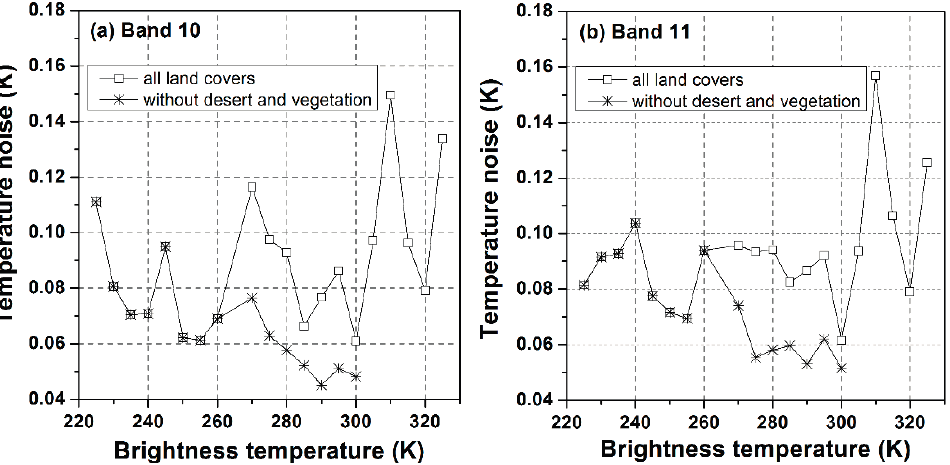
Figure 4. Variation of temperature noise with brightness temperature for the TIRS two bands. Unfilled squares stand for the noise calculated from all land covers, while the stars stand for the result calculated without desert and vegetation